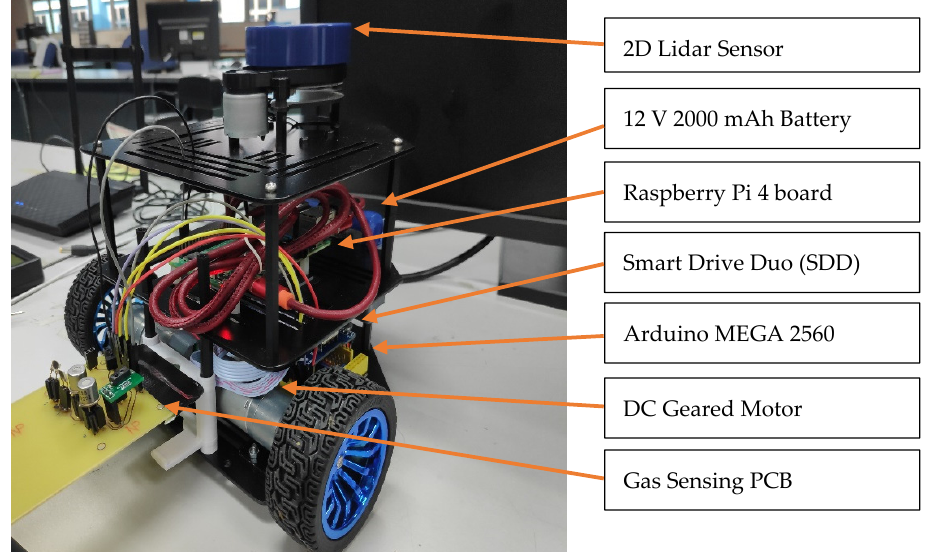
Figure 1. Bveeta Mobile Robot with Gas Sensing PCB.